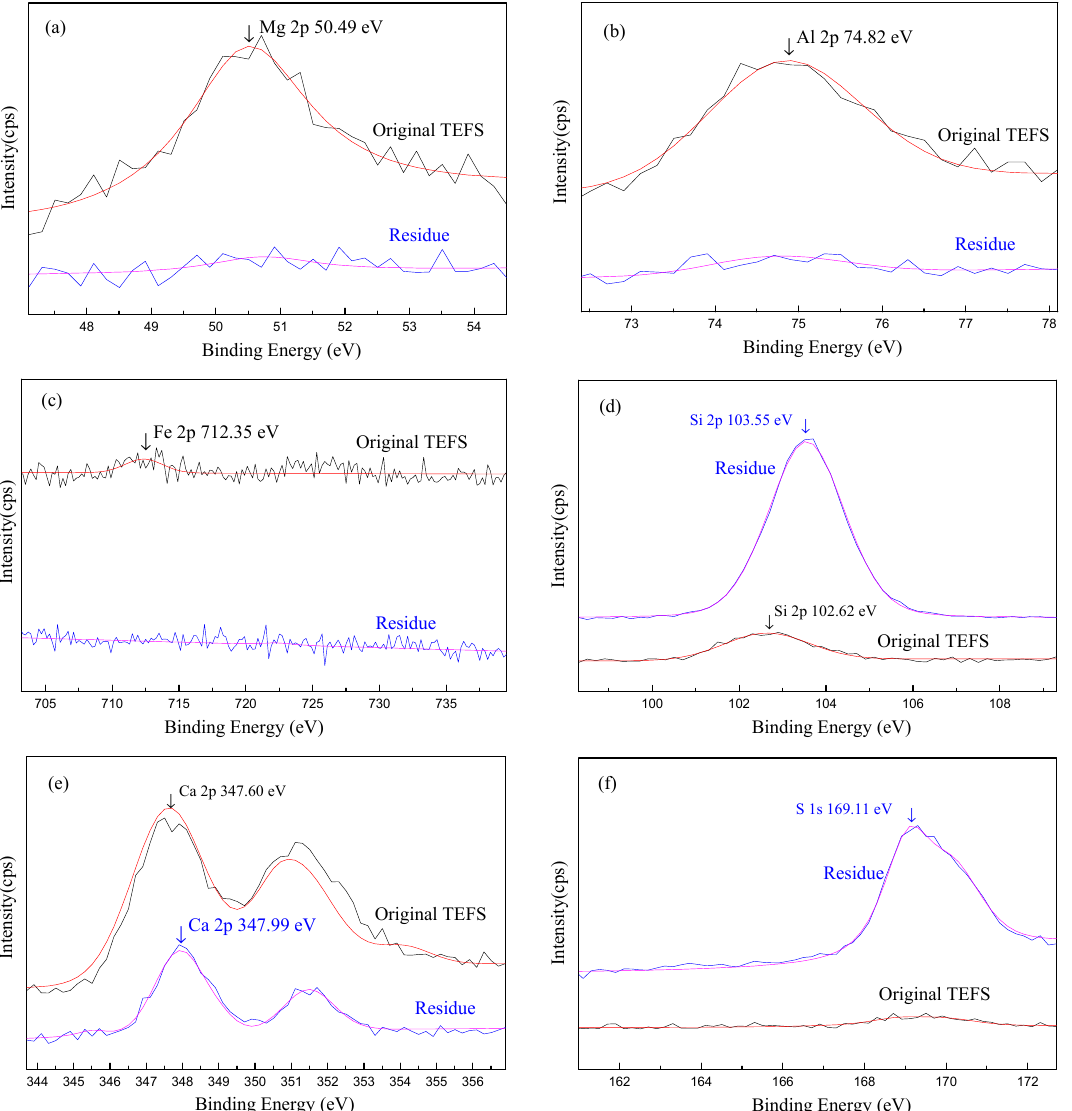
Figure 14. XPS spectra of original TEFS and residue: ( a ) Mg 2p XPS spectra; ( b ) Al 2p XPS spectra; ( c ) Fe 2p XPS spectra; ( d ) Si 2p XPS spectra; ( e ) Ca 2p XPS spectra; ( f ) S 2p XPS spectra.